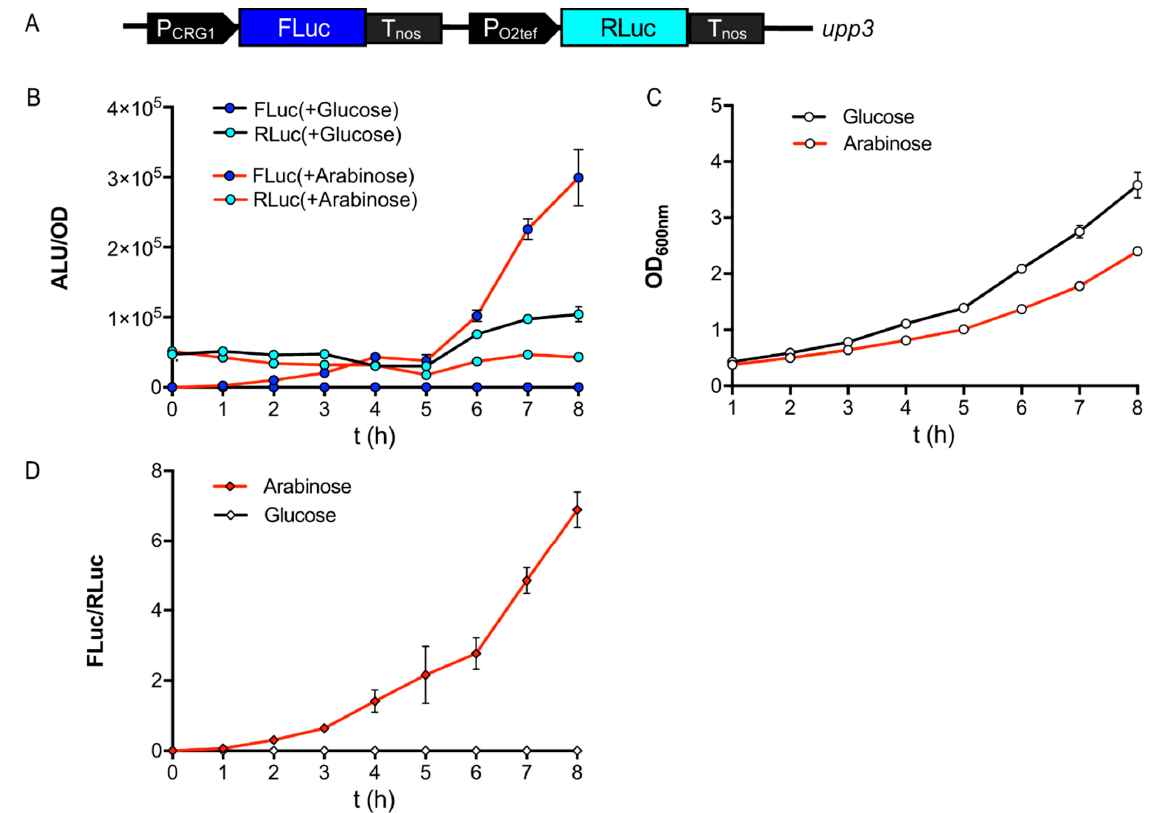
Figure 2. Ratiometric determination of inducible gene expression in U. maydis . ( A ) Structure of the FLuc/RLuc dual-reporter construct transformed into the upp3 locus of AB33 for generation of the ratiometric strain (sNH039; for detailed information, see Table S1). The normalization strain expressing FLuc under control of the arabinose-inducible promotor (P CRG1 ) and RLuc under control of the constitutive promotor PO2tef was used to calculate the FLuc/RLuc ratio for cultures in CM- glucose or arabinose medium. ( B ) Absolute luminescence of whole-cell lysates from 2 mL culture of the strains (normalized to an OD600 = 0.5). Cultures were grown overnight in CM-glucose and (i) kept in CM-glucose (black line), or (ii) shifted to CM-arabinose at time-point 0 for determinations (red line). Samples were taken for lysates every hour and analyzed for FLuc (blue dots) and RLuc (cyan dots) luminescence. ( C ) Growth of the transformed strains in CM-glucose or arabinose (in panel A, B) over a time period of 8 h, followed as OD 600 . ( D ) FLuc to RLuc ratio of the normalization strain over time. Error bars represent the SEM of this individual experiment with n = 3.